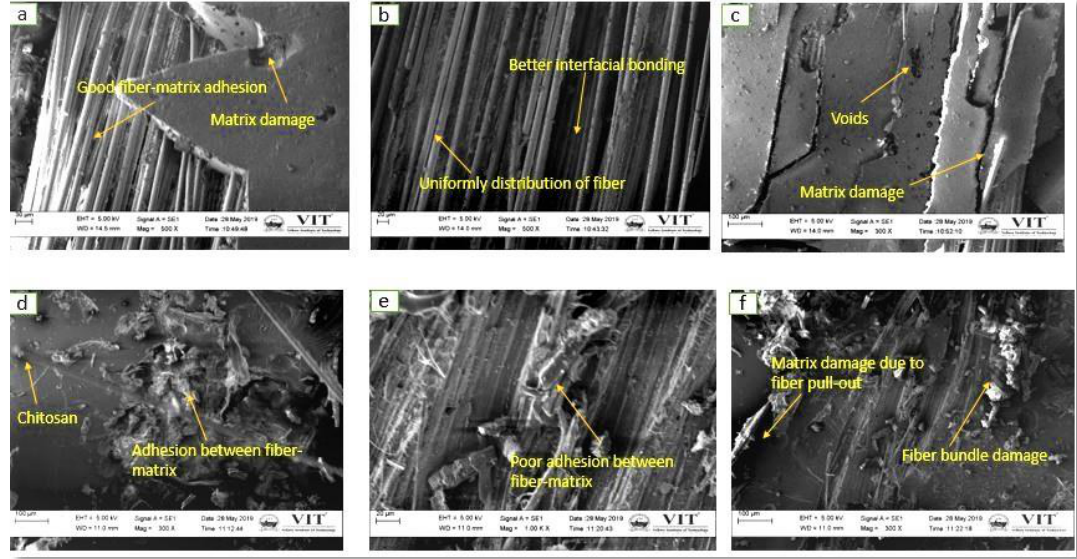
Figure 10. Tensile fractured surface of different composite: ( a ) A1 ( b ) A2 ( c ) A3 ( d ) A4 ( e ) A5, and ( f )